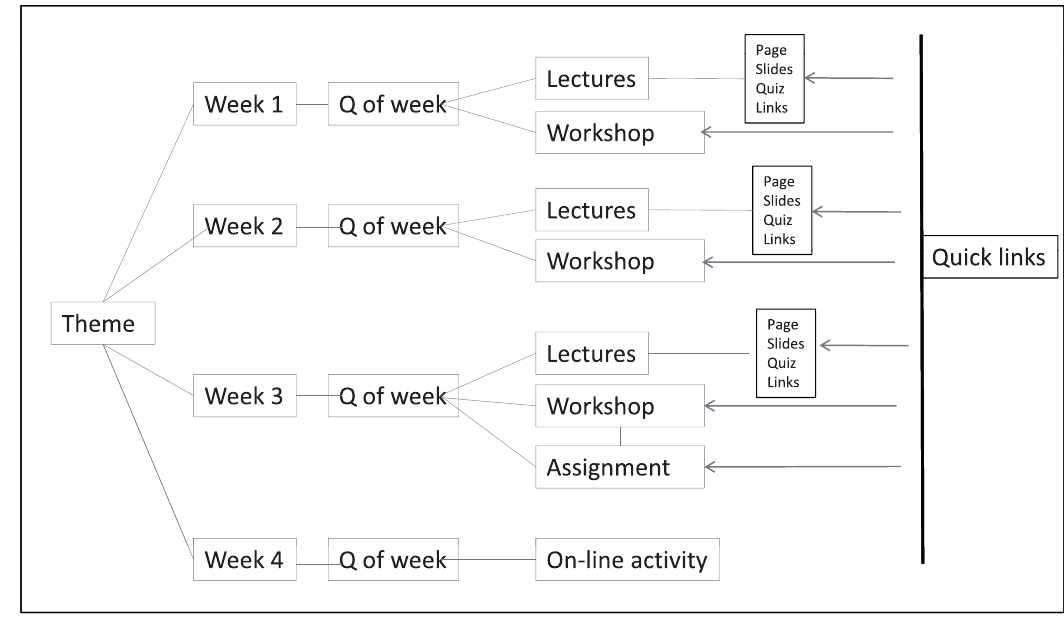
Figure 5. Schematic of layout of the page and logic connecting the various activities available through the learning management system.